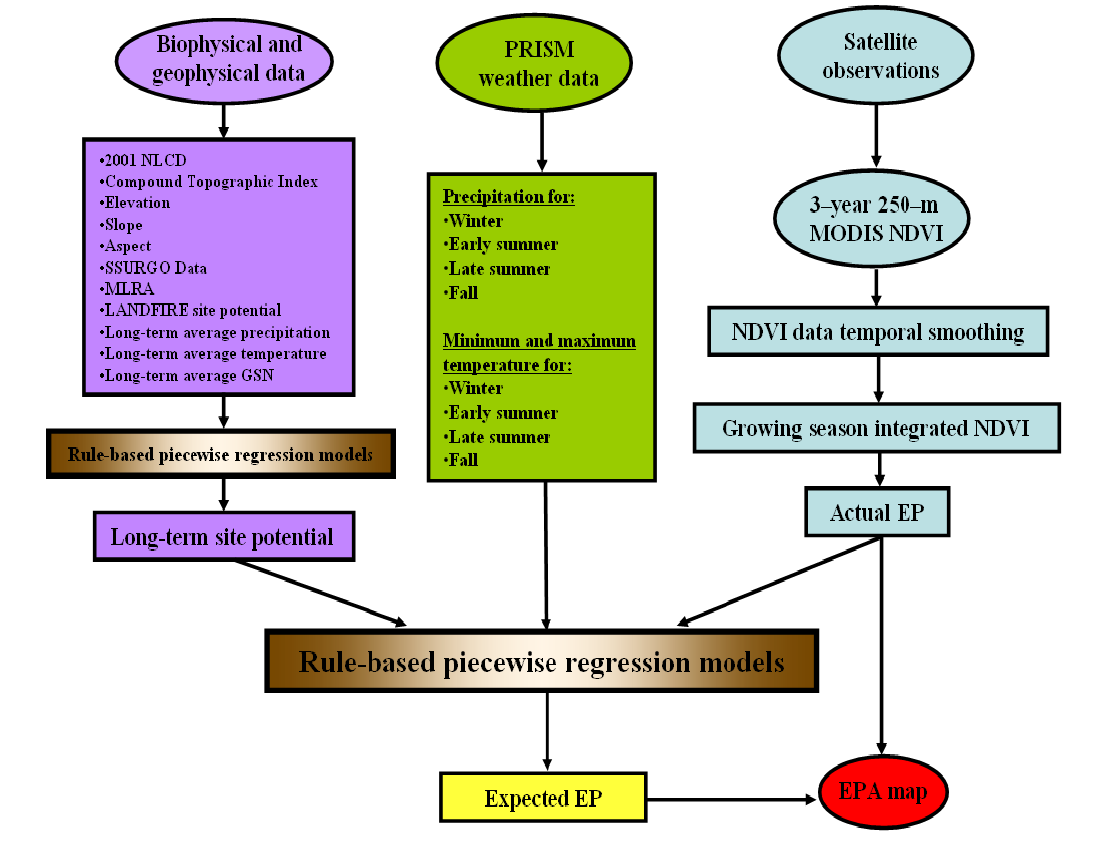
Figure 2. Flowchart for mapping ecosystem performance anomalies for land management using satellite observations, climate data, and ecological